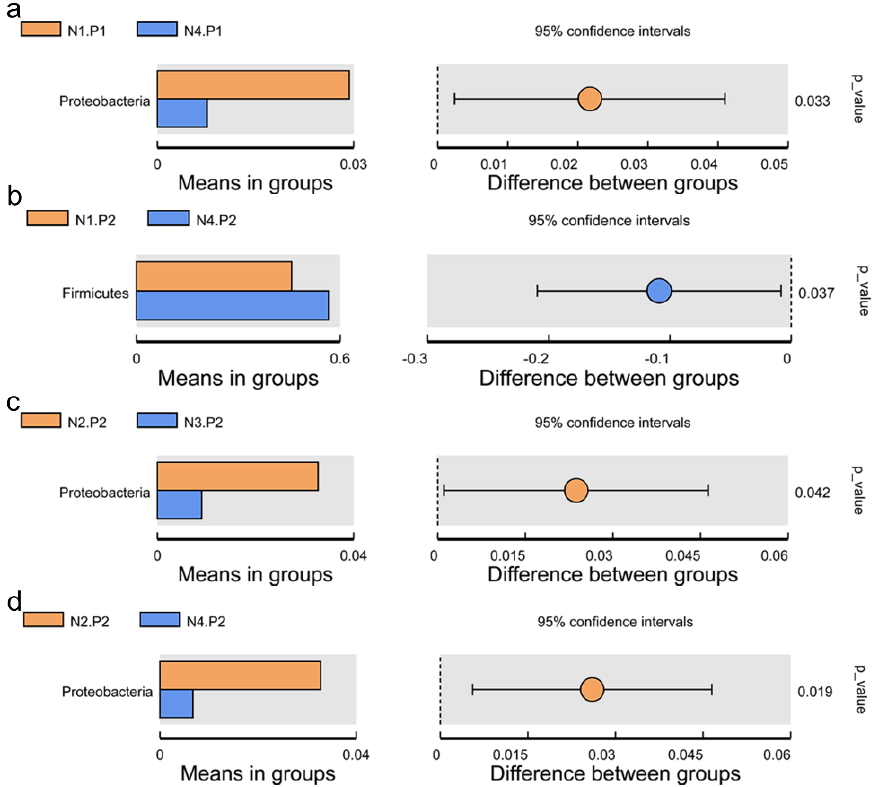
Figure 4. Species between-group difference test (phylum level). ( a ), t -test between N1.P1 group and N4.P1 group; ( b ), t -test between N1.P2 group and N4.P2 group; ( c ), t -test between N2.P2 group and N3.P2 group; ( d ), t -test between N2.P2 group and N4.P2 group. P1: the experimental period is 7 days. P2: the experimental period is 14 days. N1: 22.5 mg/kg niacin group. N2: 30 mg/kg niacin group. N3: 45 mg/kg niacin group. N4: 75 mg/kg niacin group.